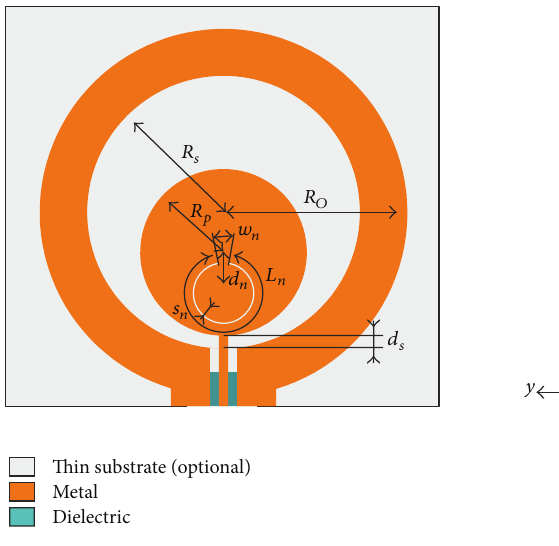
Figure 5: Geometry of the antenna.